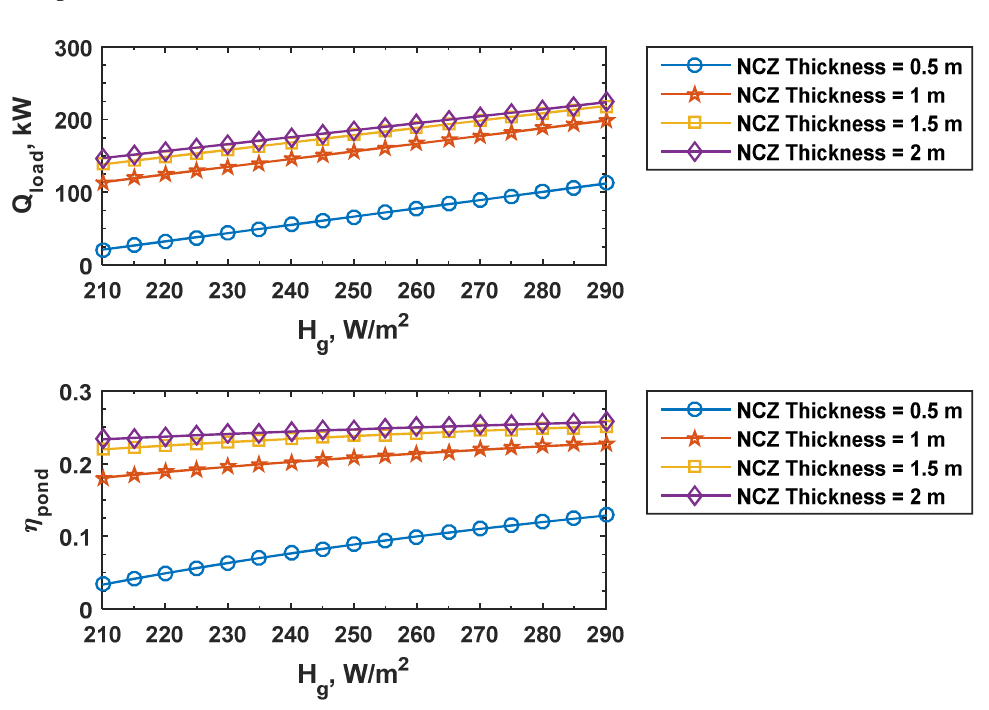
Figure 6. Effect of annual average ambient temperature on the performance of the pond.